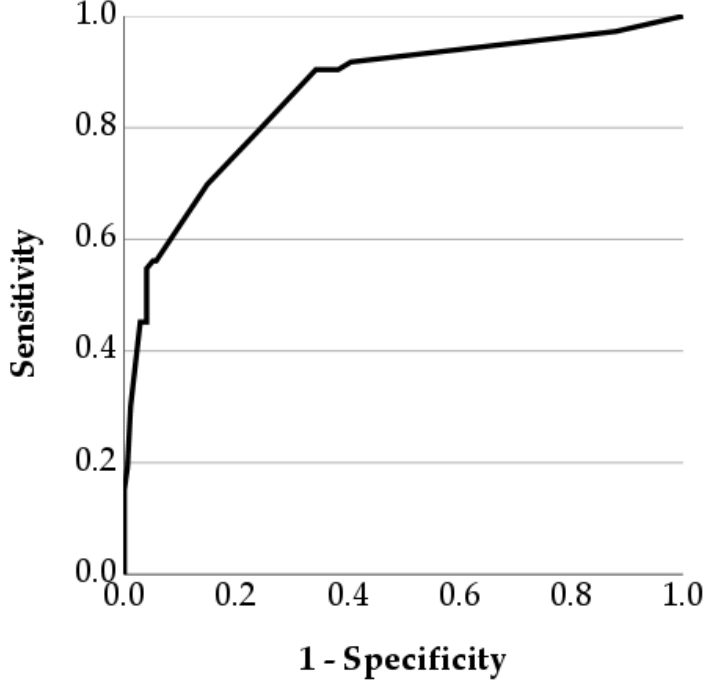
Figure 1. Receiver operating characteristic (ROC) curve of the oral frailty prediction model for the testing set. The area under the curve (95% confidence interval) was 0.860 (0.806–0.915).